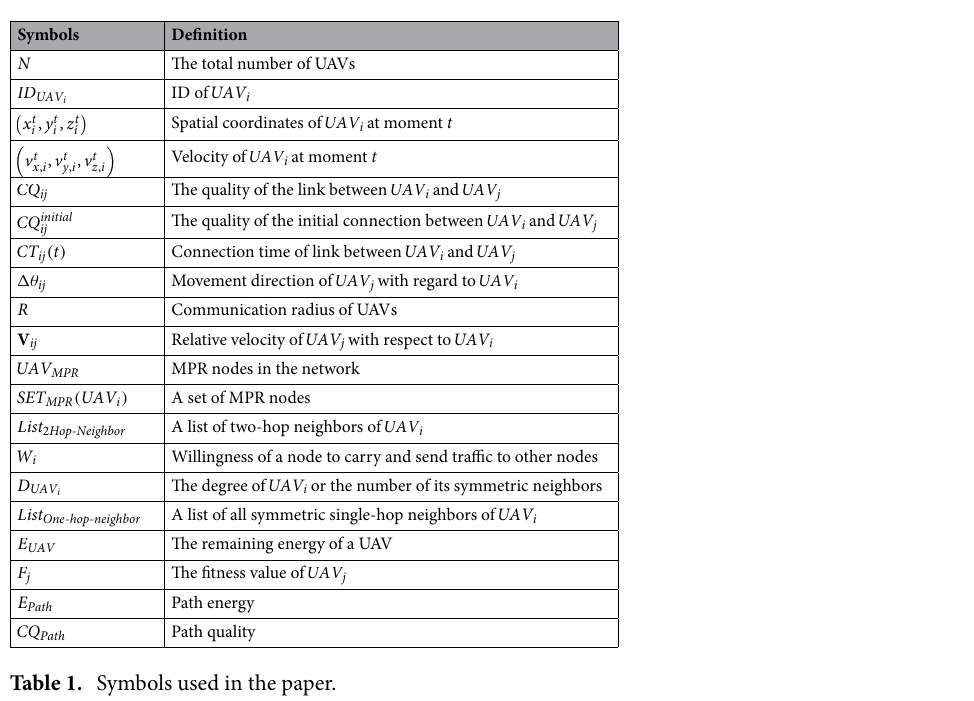
Table 1. Symbols used in the